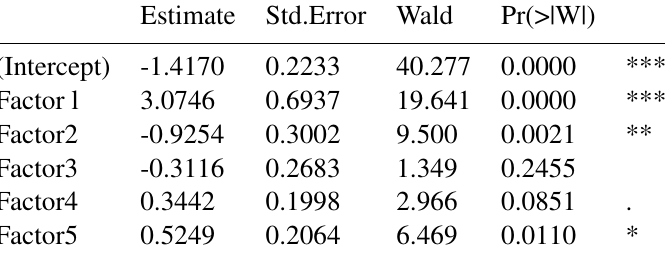
Table 2 Estimation results of generalized estimation equation.